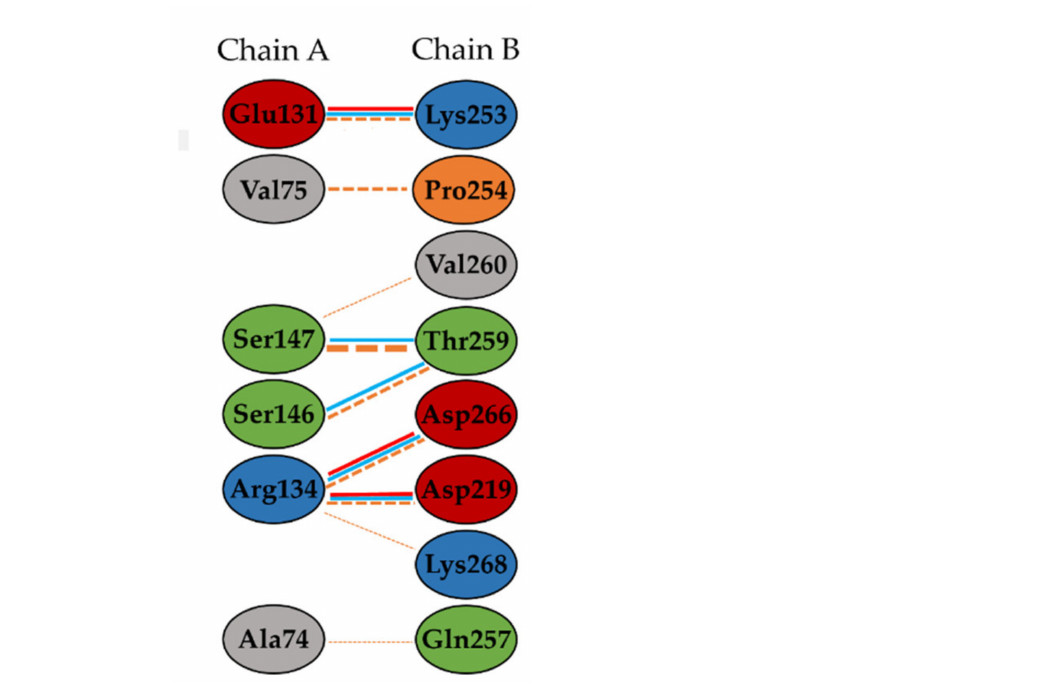
Figure 2. Interactions between chain A and chain B in TMV CP [74]. The protein residues are represented as follows: the negatively charged residues are indicated in red, positive residues are in cyan, neutral residues are shown in green; aliphatic residues are grey; Pro and Gly are orange. H-bonds are depicted as cyan lines; salt bonds are reported as red lines; non-bonded contacts are light orange dotted lines. The number of H-bond lines between any two residues indicates the number of potential hydrogen bonds between them. The width of the striped line of non-bonded contacts is proportional to the number of atomic